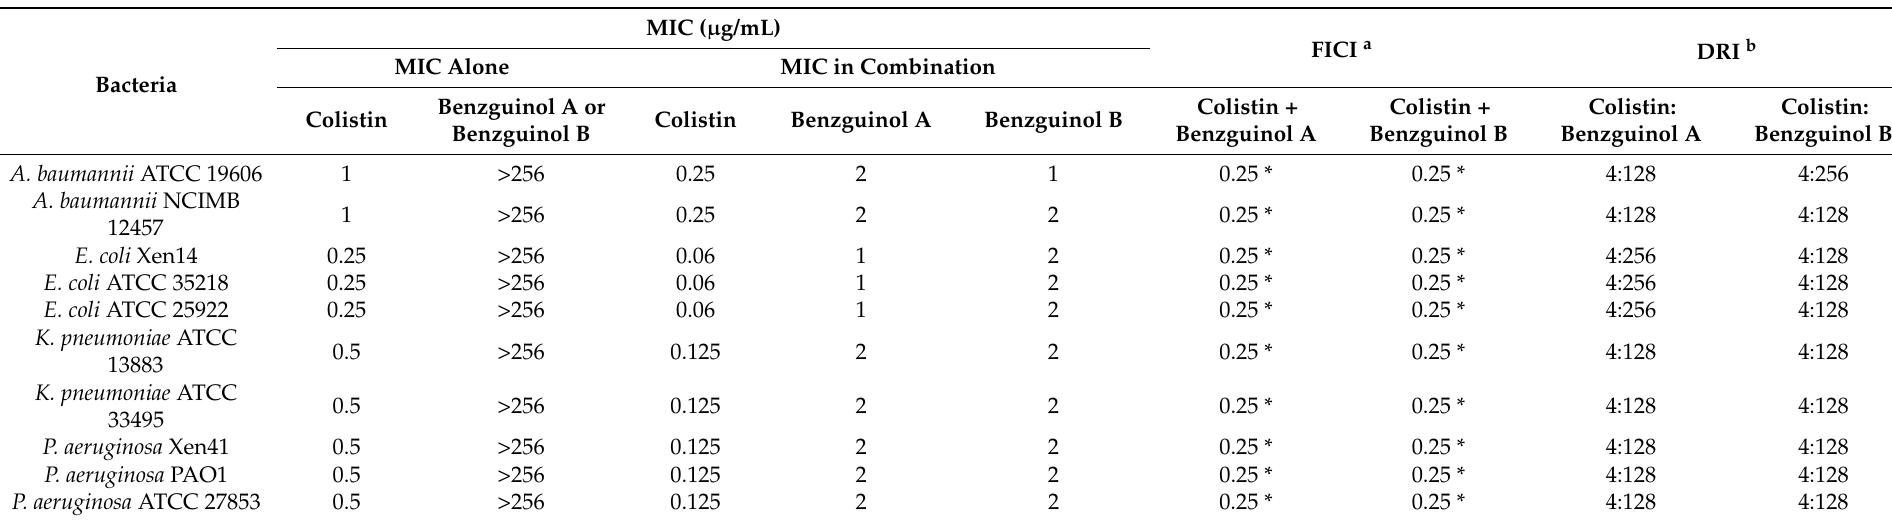
Table 2. In vitro activities of benzguinols A and B against Gram-negative bacteria in the presence of sub-inhibitory concentrations of colistin.